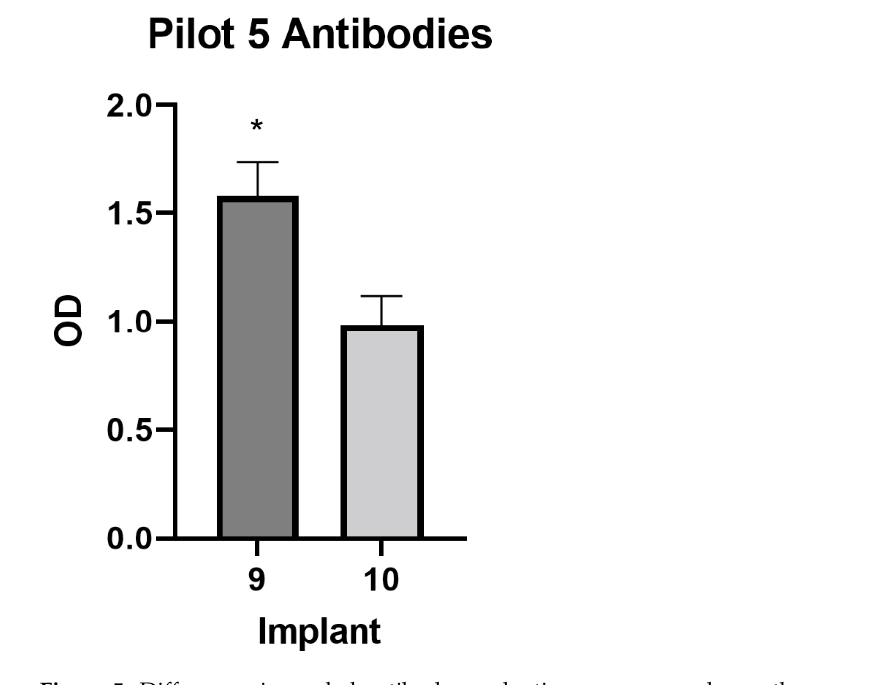
Figure 5. Differences in pooled antibody production, as measured over the course of Pilot 5. An asterisk (*) denotes a significant ( p < 0.05) difference in optical density (OD), indicative of antibody concentration.